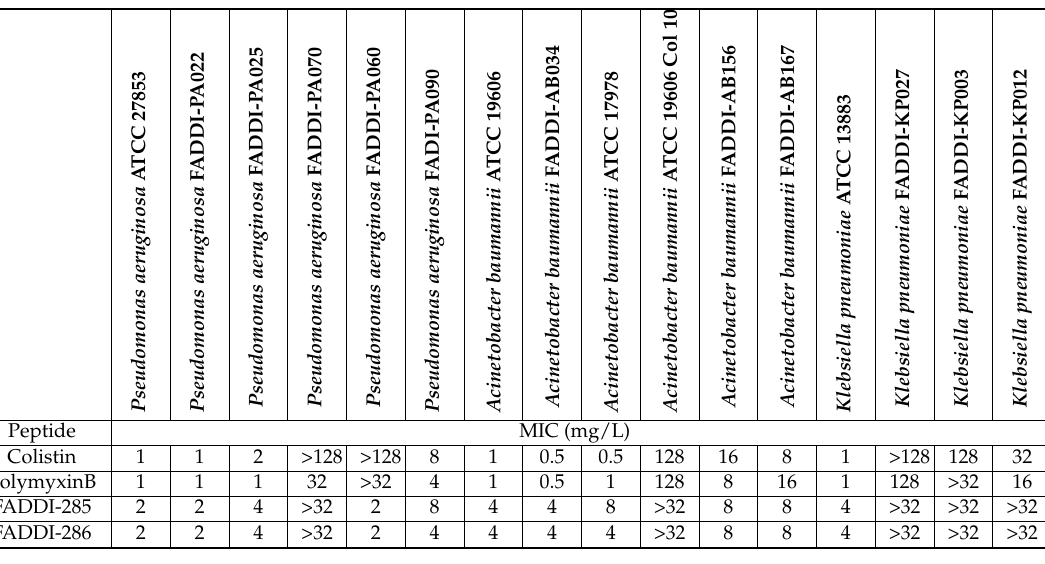
B remain at the forefront of last-line therapeutics against MDR Gram-negative “superbugs”